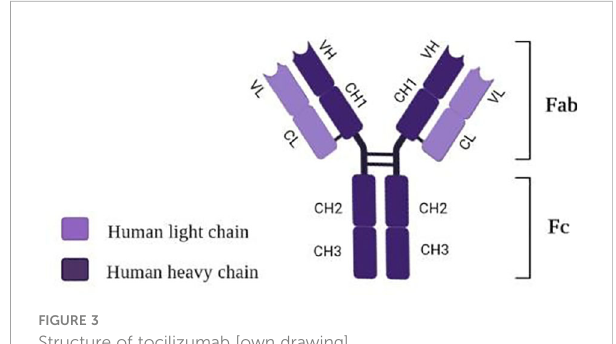
FIGURE 3 Structure of tocilizumab [own